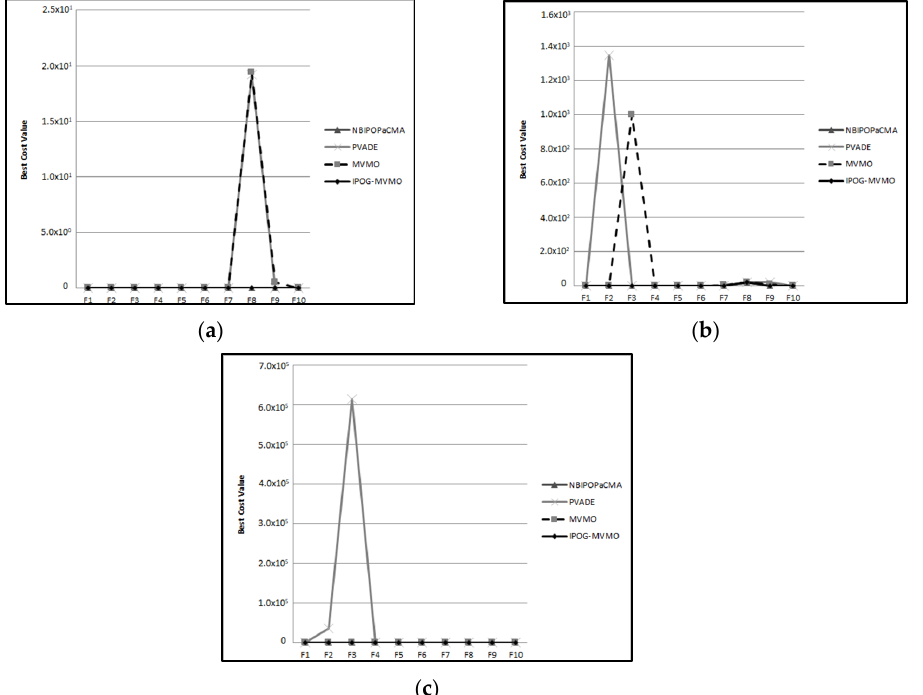
Figure 1. Comparison of the best cost value for F1 – F10 at ( a ) 10 dimensions, ( b ) 30 dimensions, and ( c ) 50 dimensions.